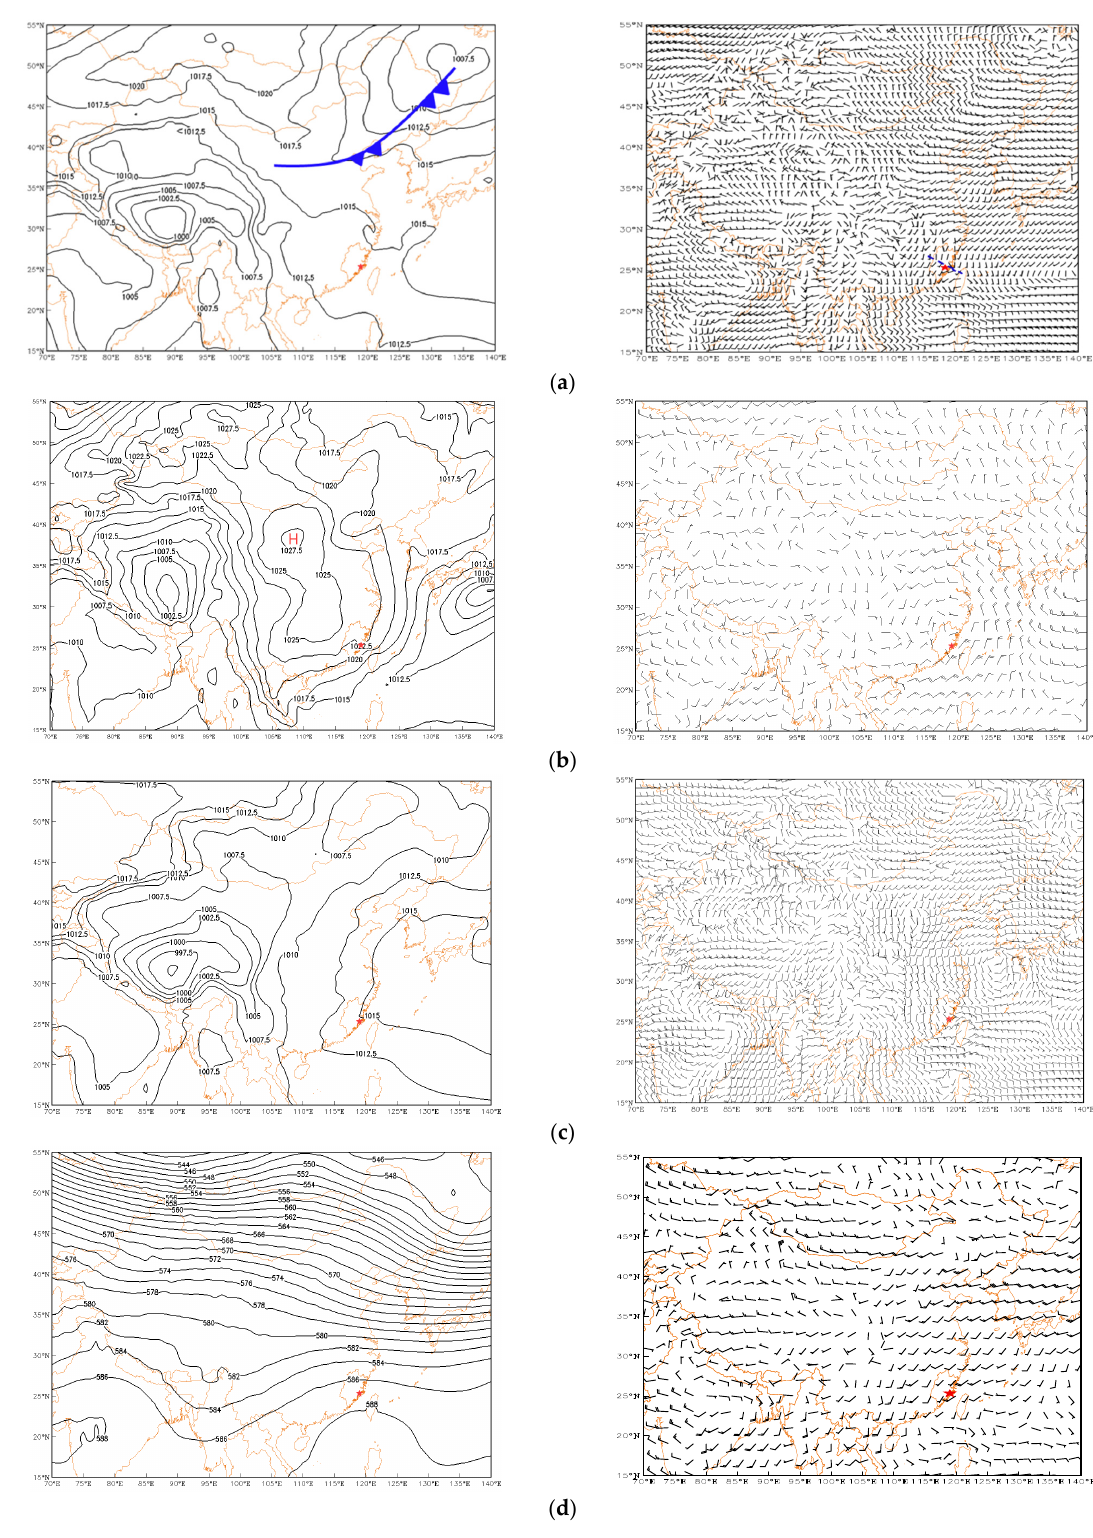
Figure 3. The mean sea-level pressure field and wind field at 925 hPa for each SWP during the polluted days from 2015 to 2020. Sea-level pressure (( a – c ) left); 925 hPa wind (( a – c ) right) 500 hPa geopotential height (( d ) left); 925 hPa wind (( d ) right); the star represents the study area. ( a ) Warm sector ahead of front—Type FS; ( b ) cold high-pressure ridge—Type GN; ( c ) transformed surface cold high—Type GS; ( d ) edge of subtropical high pressure—Type